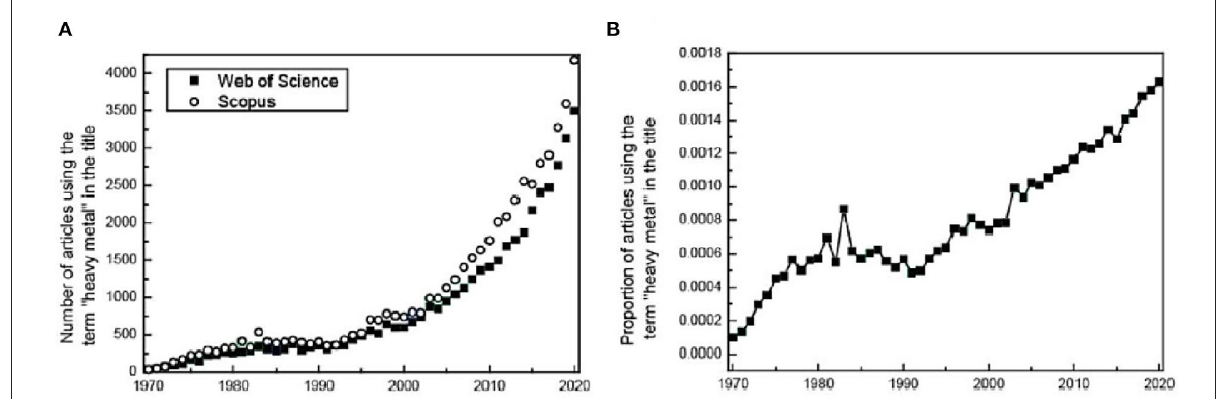
FIGURE2 (A) Evolution of the number of publications using the term “heavy metal*” in their titles (Scopus and Web of Science, 24 February 2021). Modified and updated from Pourret and Bollinger (2018) and Pourret and Hursthouse (2019). (B) Evolution of publications using the term “heavy metals” in their titles (number of articles using the term divided by the total number of all articles published in the year) (Scopus data, searched using “heavy metal*”, accessed 24 February